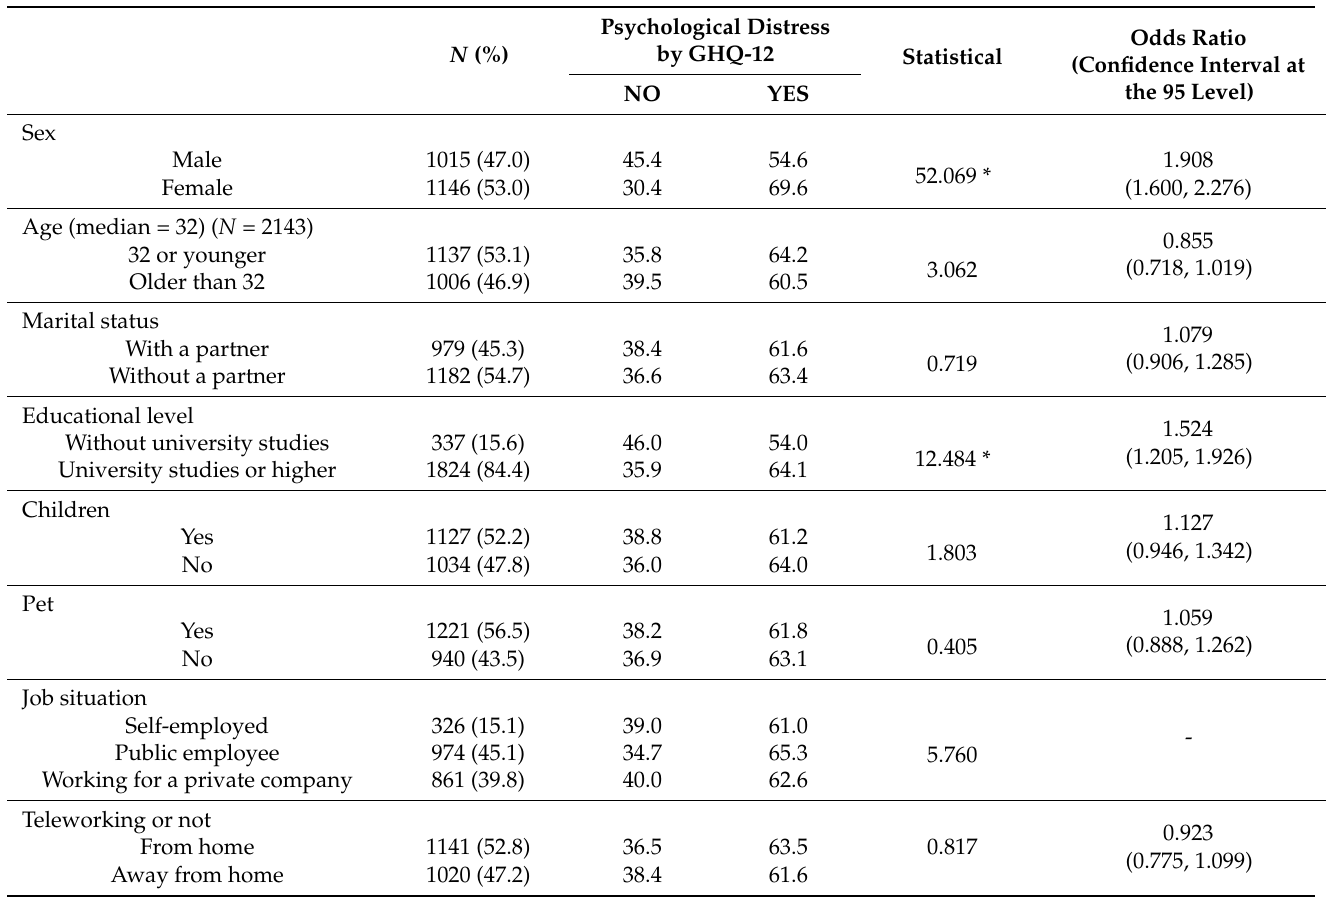
Table 3. The associations between the sociodemographic variables and psychological distress ( N = 2161).